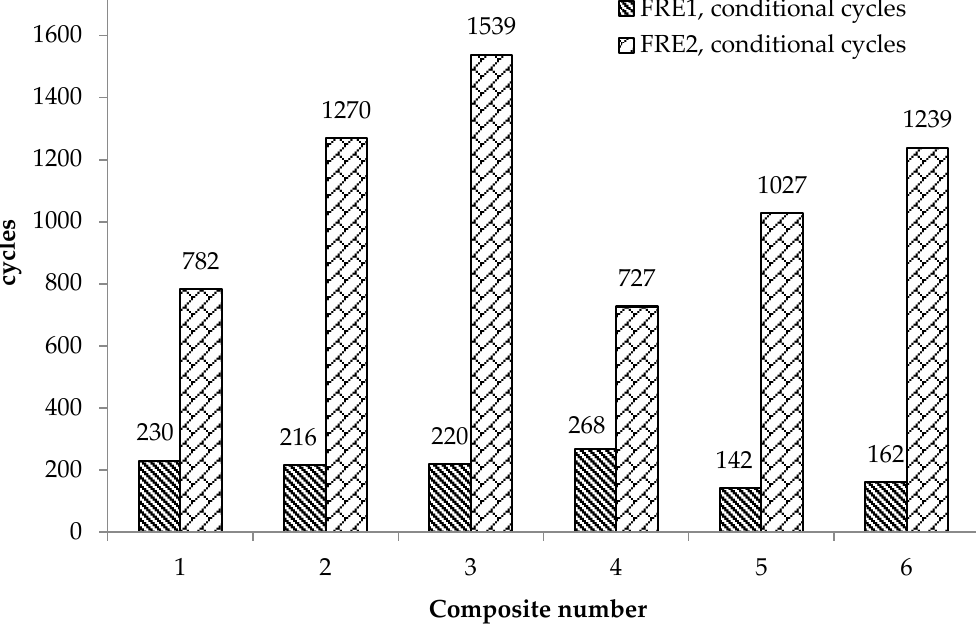
Figure 8. Predicted operational cold resistance values for the conditional cycles at the start of decomposition and the end of decomposition: 1–6—composition number of the LWC (see Table 6).